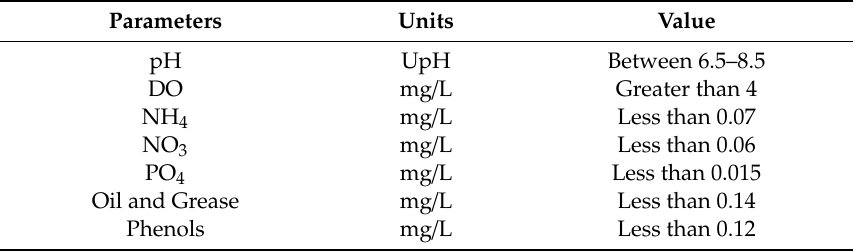
Table A2. Water quality criteria for the preservation of marine biota [41,42].